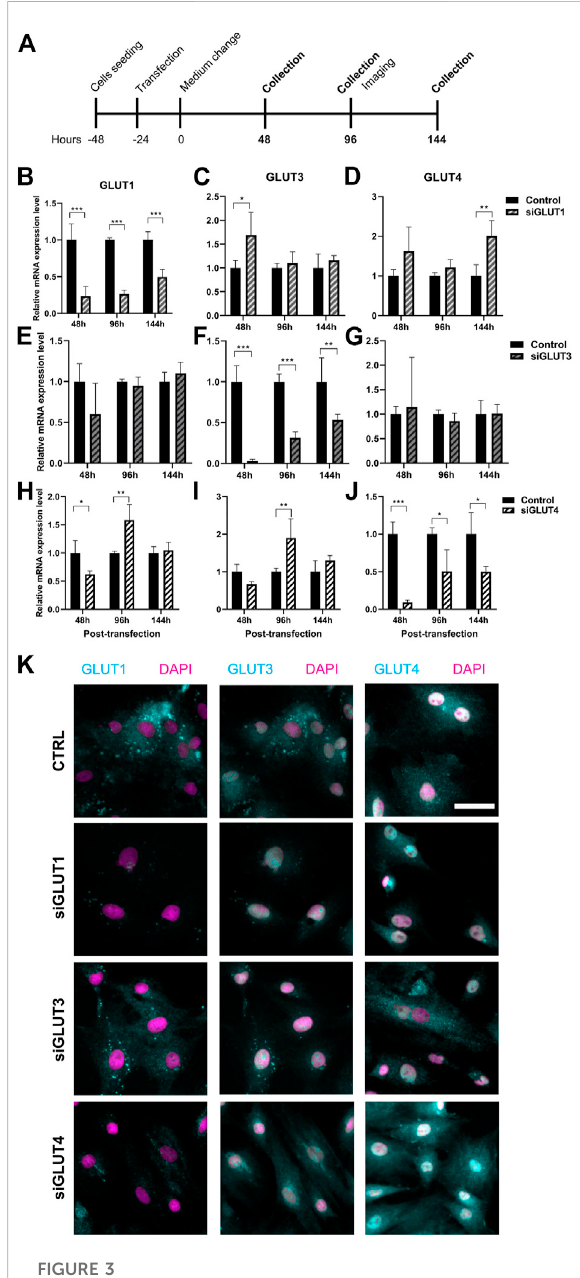
FIGURE 3 Silencing of GLUT1, GLUT3, or GLUT4. We then silenced GLUT1, GLUT3, or GLUT4 individually with siRNA-technology (A) . Cells were ef fi ciently although transiently silenced using siRNA against GLUT1 (siGLUT1, B), GLUT3 (siGLUT3, F) or GLUT4 (siGLUT4, J). Universal scramble siRNA was used as a control. siRNAswerespeci fi candnodownregulationofGLUT1,GLUT3and GLUT4 were observed (B – J) . mRNA expressions are compared againsthousekeepinggene(CyclophilinB).Notethatthe x -axisare different. GLUT1, GLUT3 and GLUT4 protein expression in osteoblasts at 96 hrs post-transfection (K) . GLUTs are shown with cyan and nucleus with magenta, scalebar 50 μ m. Note that GLUT1 and GLUT3 staining was performed as double-staining on same cells, and images are pseudo-coloured. p -values: * p < 0.05, ** p < 0.01, *** p < 0.001 (One way